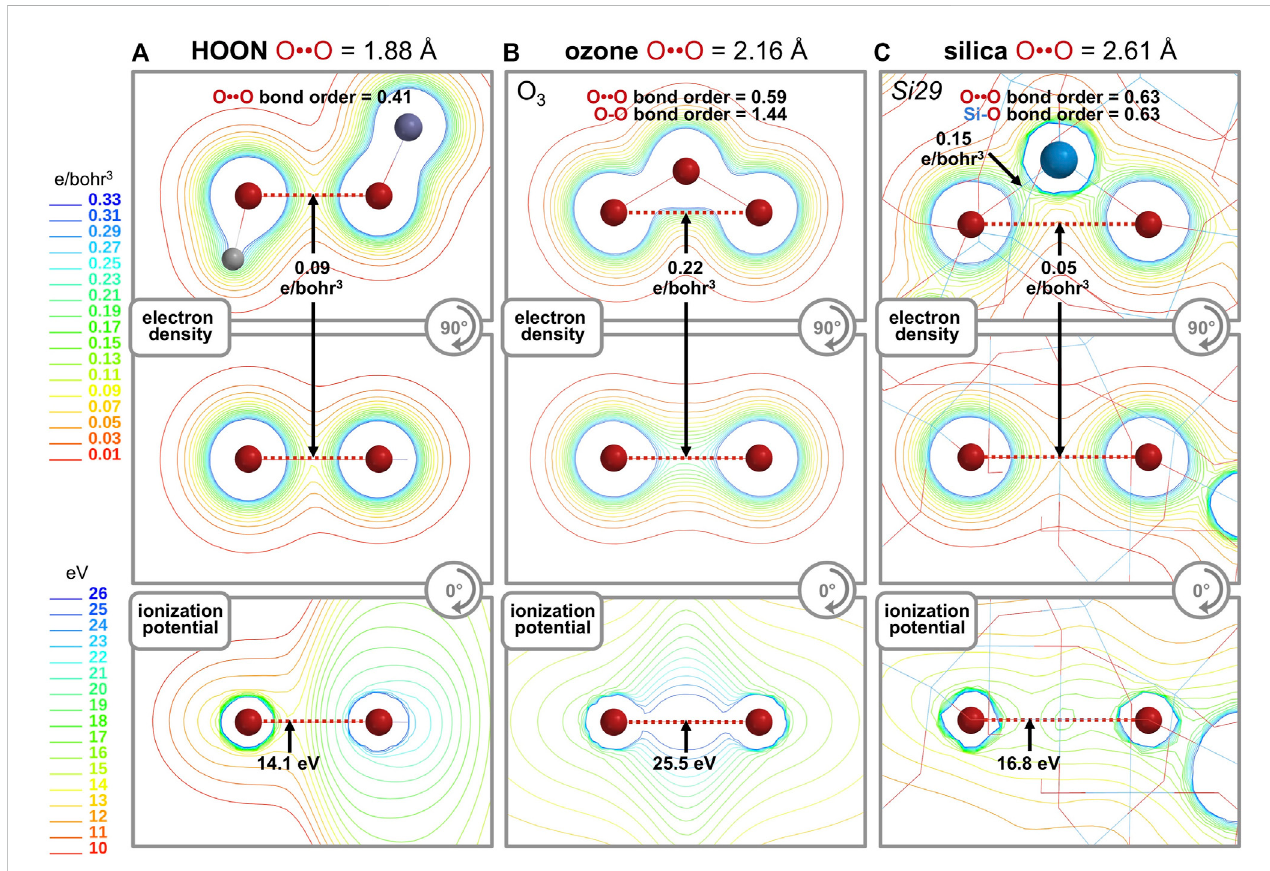
FIGURE 8 Computational analyses of HOON (A) , ozone (B) , and quartz silica (C) compare the O-O bond order, minimum O-O electron density (units of e/bohr 3 , coreplusvalence),andminimumO-Oionizationpotential(unitsofeV).Twoorthogonalcontourmapsareshownfortheelectrondensityandasinglecontour map is shown for the ionization